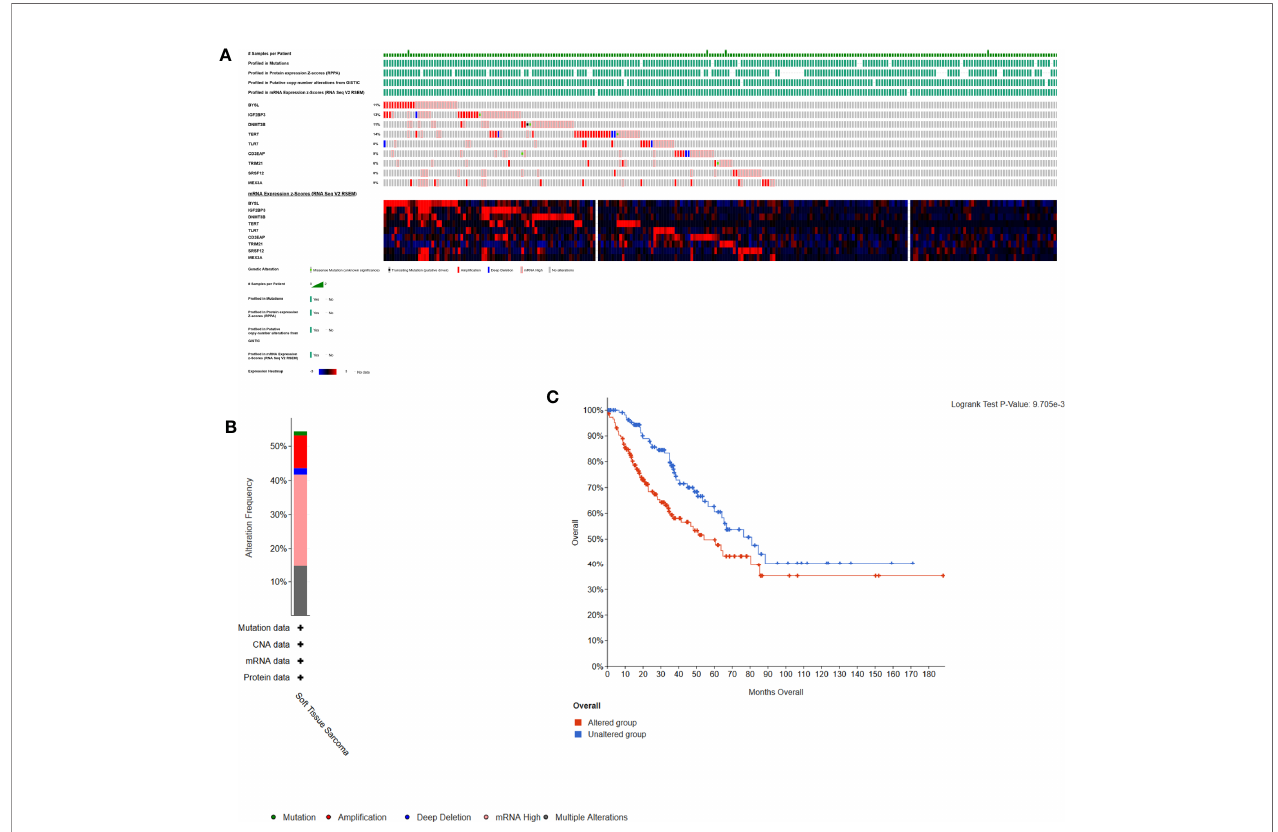
FIGURE 8 | Alterations in expression of the 9 hub RBPs. (A) A total of 148 of 261 samples (57%) had alterations of the 9 hub RBPs based on data about mutations, protein, copy-number alterations and mRNA expression. Missense Mutation(unknown signi fi cance): samples had missense mutations of RBPs with